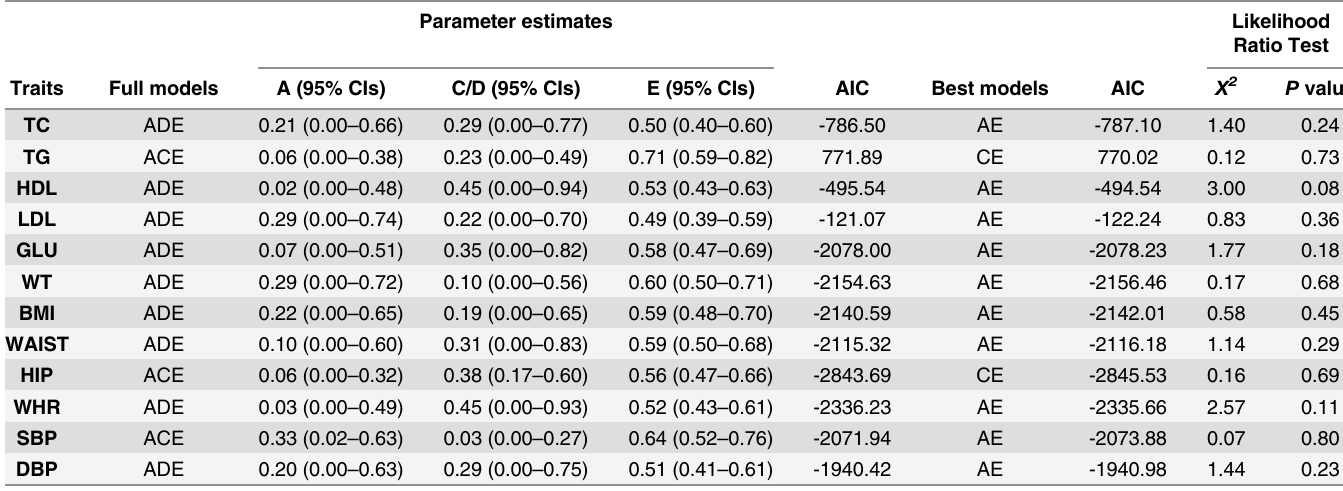
Table 3. Full models for longitudinal change of each phenotype in the Danish twins and statistics for best fitting models. Parameter estimates Likelihood